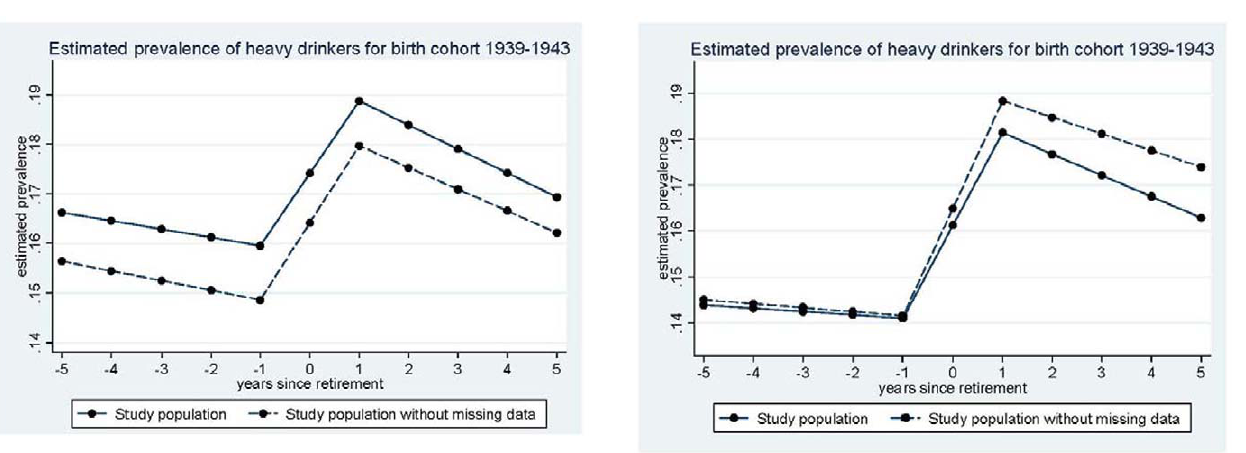
Figure 4. Sensitivity analysis for missing data - Men. doi:10.1371/journal.pone.0026531.g004 Figure 5. Sensitivity analysis for missing data -